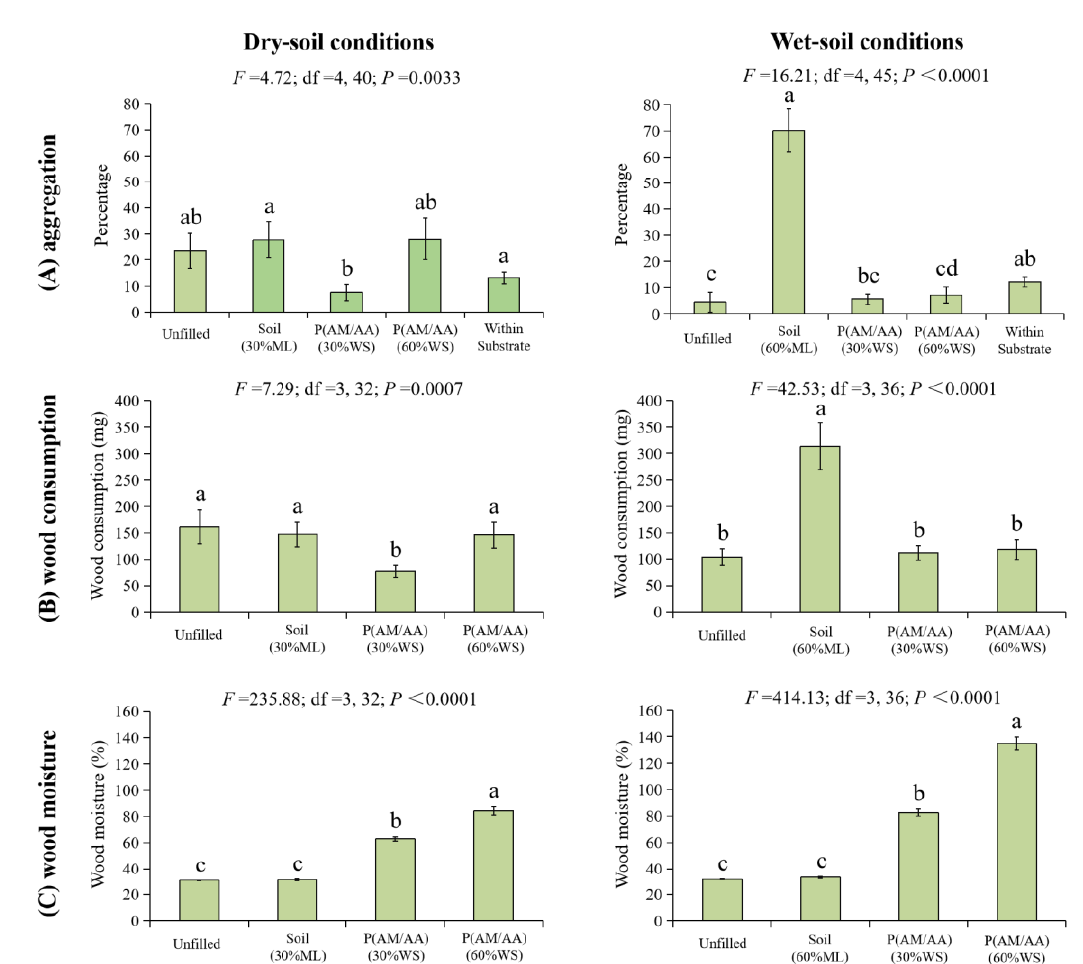
Figure 8. Results of the multiple-choice tests (under dry- or wet-soil conditions) to investigate the preference of termites to poly(acrylamide-co-acrylic acid) potassium salt (P(AM/AA)) filled in the void volume of baiting containers. Percentage of termites in each location ( A ), and wood consumption ( B ) and wood moisture ( C ) in each baiting containers are presented as mean ± SE. Different letters indicate significant differences ( p < 0.05). WS represents water saturation level.